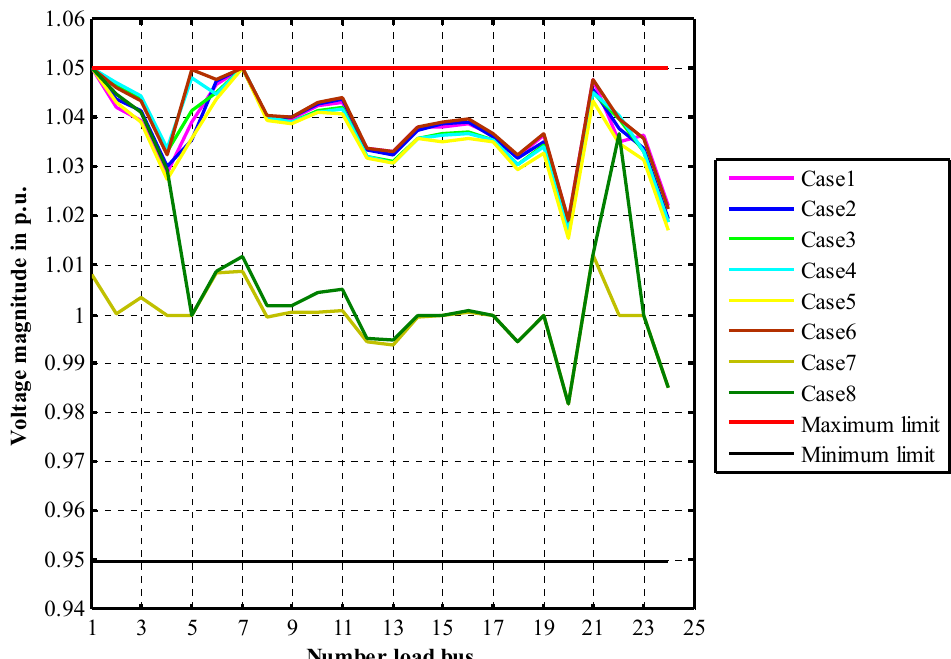
Figure 3. The voltage profile of the Cases 1 to 8.